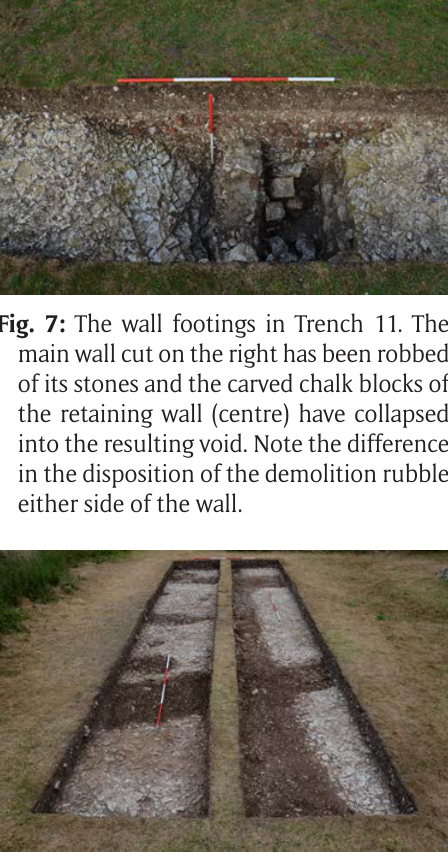
Fig. 8: Trenches 14a and b looking SE, show- ing internal footing trenches, postholes and